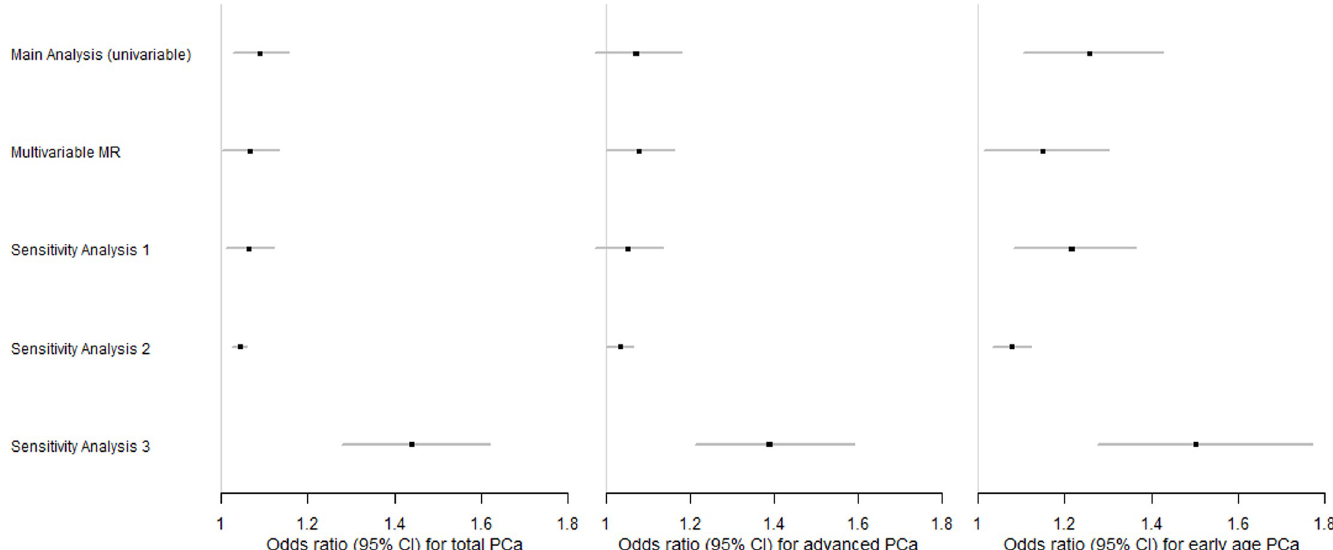
Fig 1. Forest plots of the Lp(a) effects observed in different analyses based on each PCa type. The main and sensitivity analyses estimates are based on the weighted median approach, whereas MVMR includes the IVW estimates. Sensitivity analyses 1–3 refer to the univariable models. Sensitivity analysis 1 is based on an eased clumping threshold of 0.01, Sensitivity analysis 2 includes an IV set based on another paper, and, finally, Sensitivity analysis 3 is based upon variants located in the LPA gene. Each square represents the OR for each PCa outcome, reported per SD increase in the biomarker, with the 95% CI represented by the error bars. IV, instrumental variable; IVW, inverse variance weighting; Lp(a), lipoprotein A; MVMR, multivariable MR; OR, odds ratio; PCa, prostate cancer; SD, standard deviation.